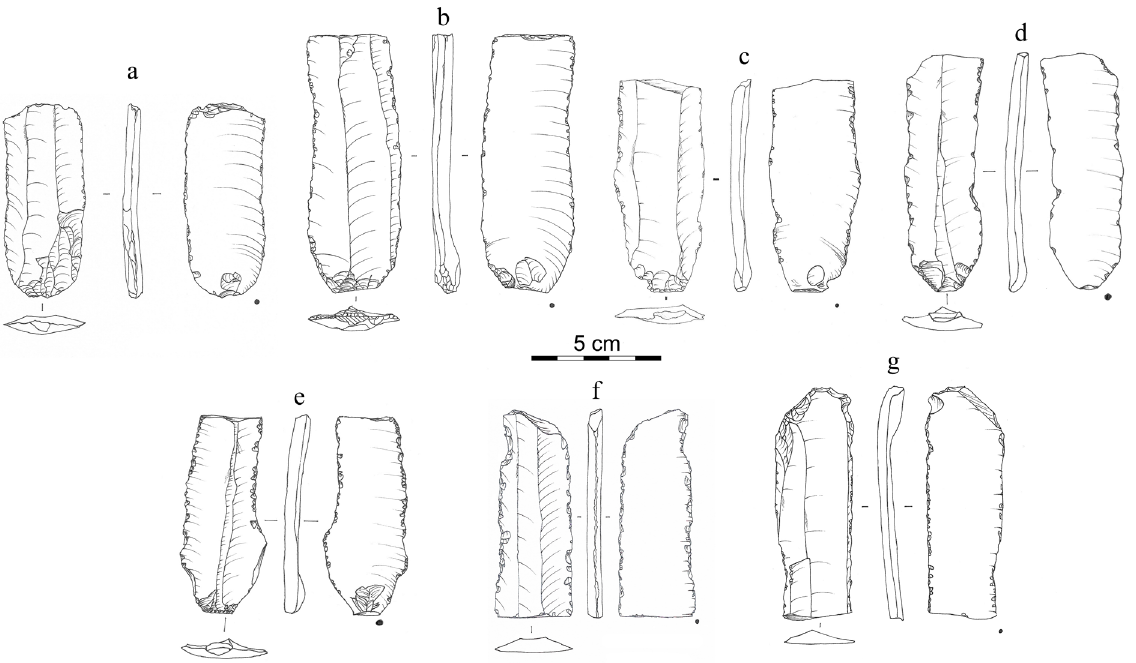
Figure 3. Tronçons de lames d’Aknashen fabriqués par pression au levier. Figure 3. Segments of blades from Aknashen knapped by pressure with a